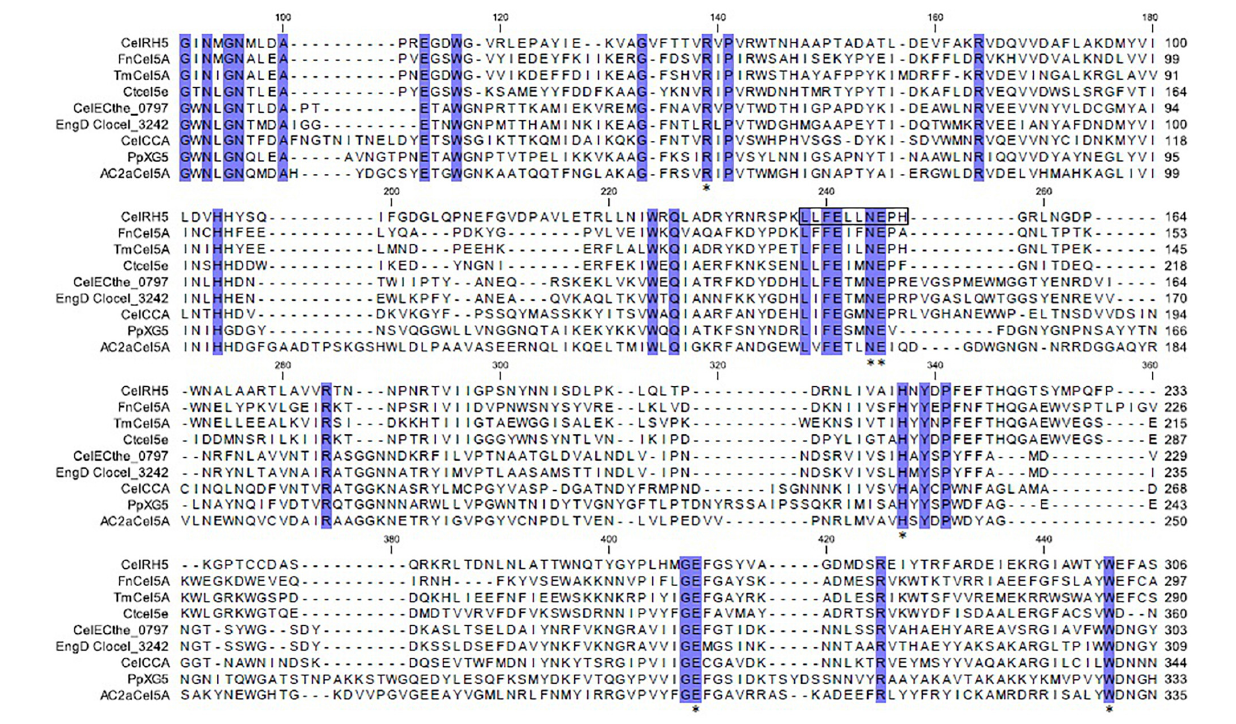
FIGURE 1 | Multiple alignments of CelRH5 with the eight most homologous GH5 proteins deposited in the PDB database. Identical residues are shaded with a blue background. Fragment estimated with Inter ProScan as the catalytic site is marked with a black rectangle. The star symbol ( ∗ ) indicates the conserved residues in the substrate-binding pocket as determined by 3D structure